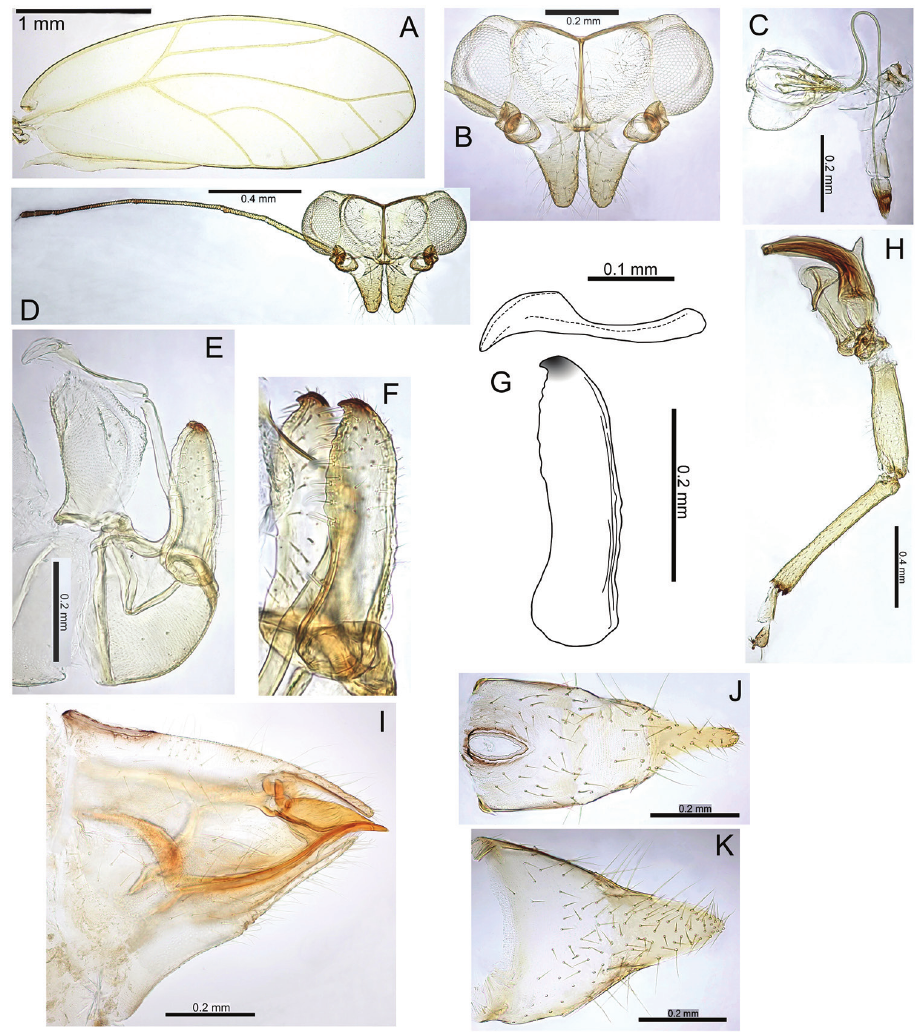
Figure 39. Pariaconus kupua sp. n. A fore wing B head C proboscis D head and antenna E male ter- minalia F parameres G aedeagus and paramere H hind leg I female terminalia J female proctiger (dorsal view) K female subgenital plate (ventral